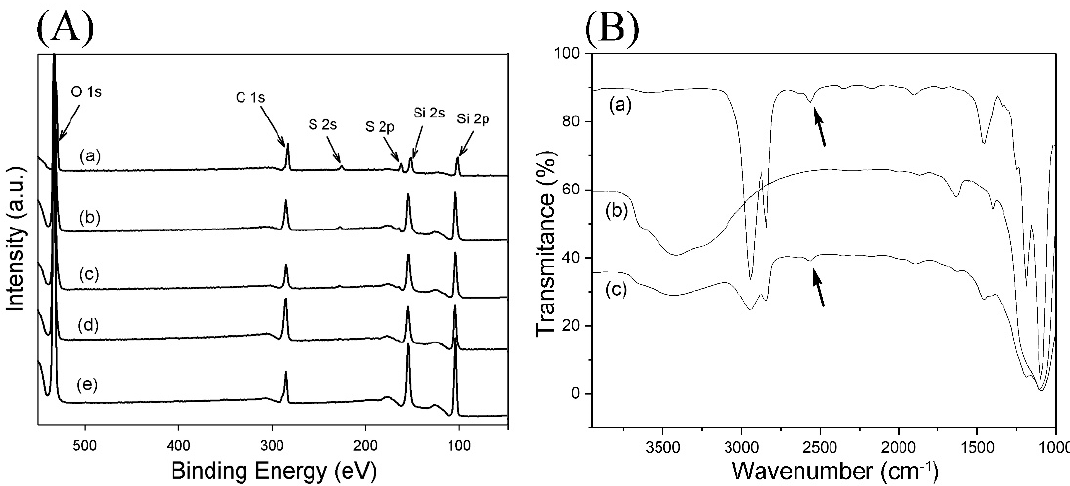
Figure 2. ( A ) XPS profiles of (a) 12 nm-SiO 2 -SH, (b) 80 nm-SiO 2 -SH, (c) 150 nm-SiO 2 -SH, (d) 350 nm- SiO 2 -SH, and (e) unmodified 12 nm-SiO 2 ; ( B ) FT-IR spectra of (a) MPTMS, (b) 12 nm-SiO 2 , and (c) 12 nm-SiO 2 -SH.